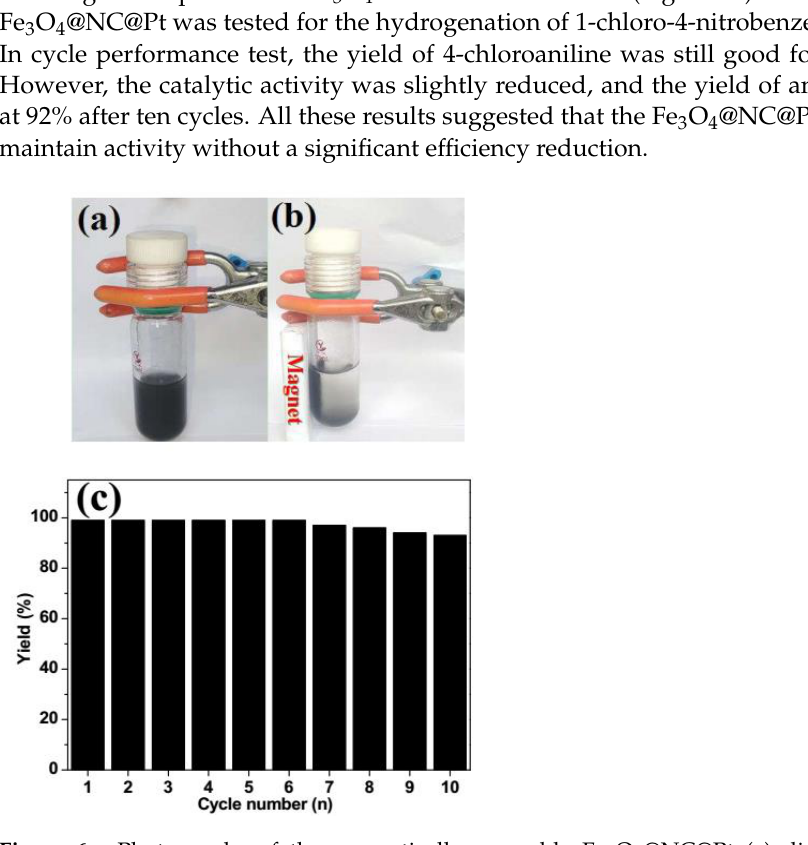
Figure 6. Photographs of the magnetically separable Fe 3 O 4 @NC@Pt ( a ) dispersion state of